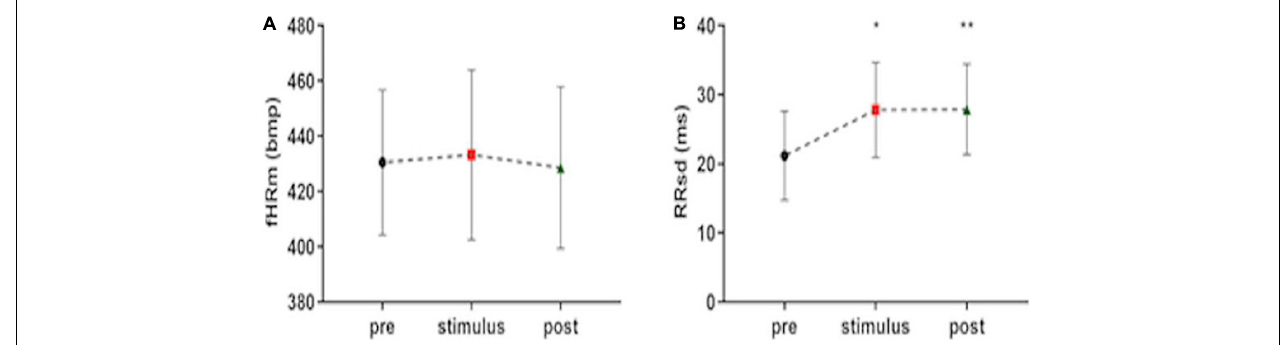
FIGURE 2 | Fetal heart rate mean (A) and heart rate variability, expressed ad RRsd (B) during FANTE data collection. pre, basal FANTE data collection; stimulus, stimulus FANTE data collection; post, post-stimulus FANTE data collection. *significant at the alpha level p < 0.05; **significant at the alpha level p < 0.01. TABLE 2 | Features extracted from the RR series in the different phases of the protocol. Pre Mean ± SD Stimulus Mean ± SD Post Mean ± SD Pre vs. Stimulus Pre vs. Post Stimulus vs.